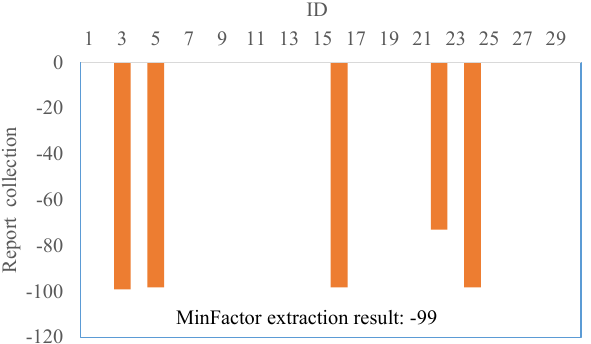
Figure 8. Collection of reports at the edge server in Scenario 1 regarding the proposed scheme.